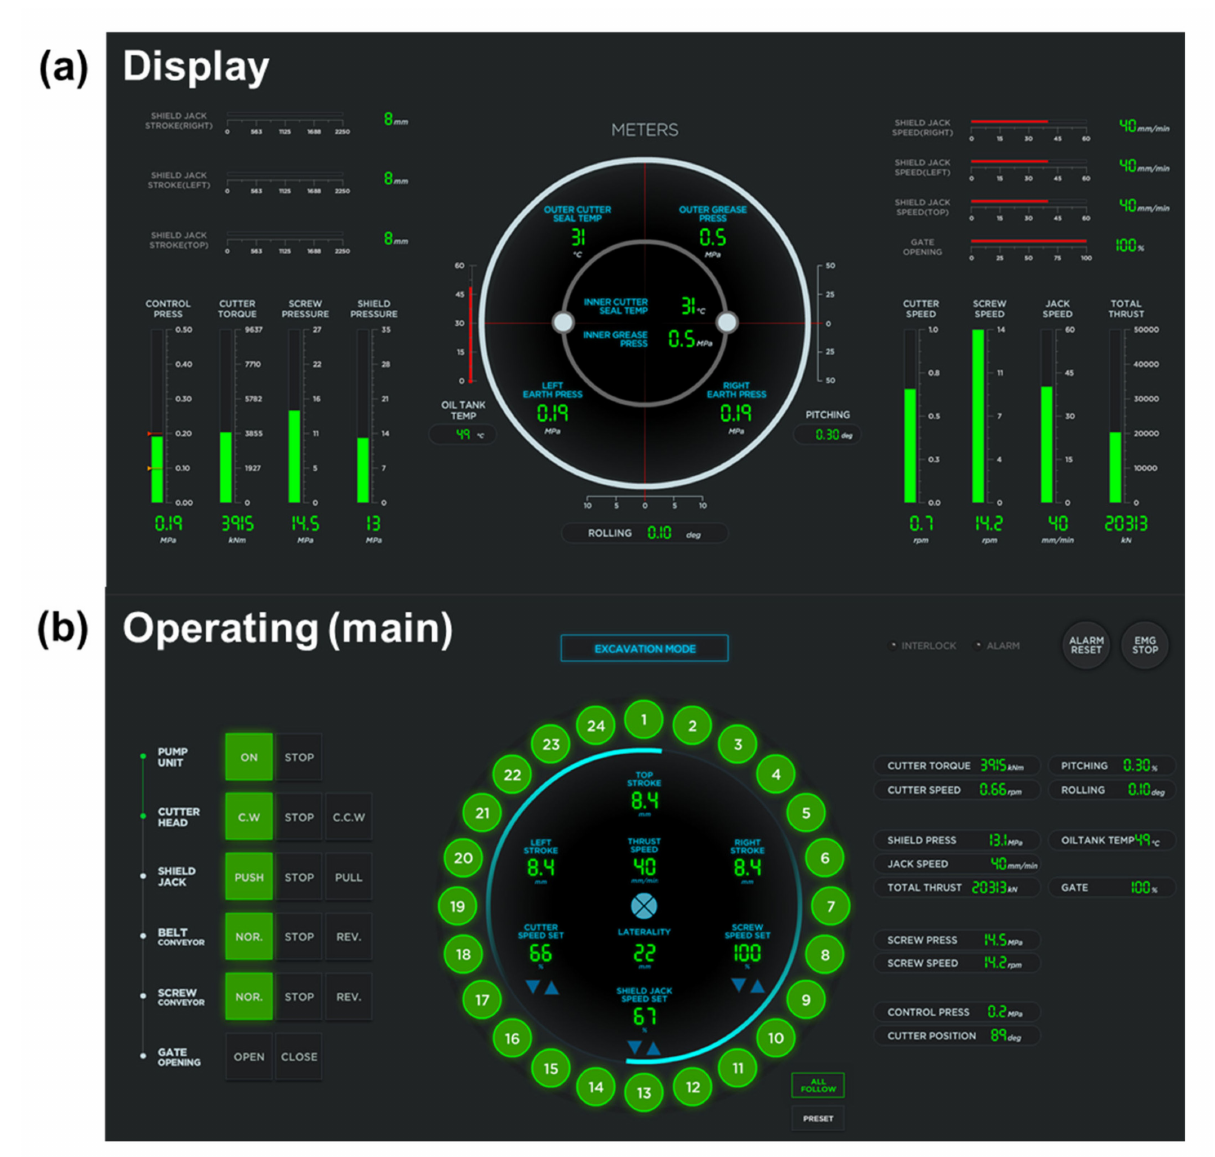
Figure 8. ( a ) Display and ( b ) main operating panels in the TBM simulator. Figure 9a shows the configuration panel. Elective interlock systems are confirmed on the left, with each able to be activated independently if the system is set to monitor . On the right, upper, and lower limits of earth pressure can be determined. Figure 9b shows the simulator warning alarm panel, which displays information about alarm systems (Table 6). When a specific operating parameter has an abnormal value, the warning alarm light is turned on and displayed in a box at the bottom of the panel. Among the four columns, the left two are the first stage for warning , and the right two are the second stage for error . As an extra training tool, the instructor panel allows the trainer to introduce unexpected situations by manipulating any of the mechanical responses, regardless of the trainee’s operation actions (Figure